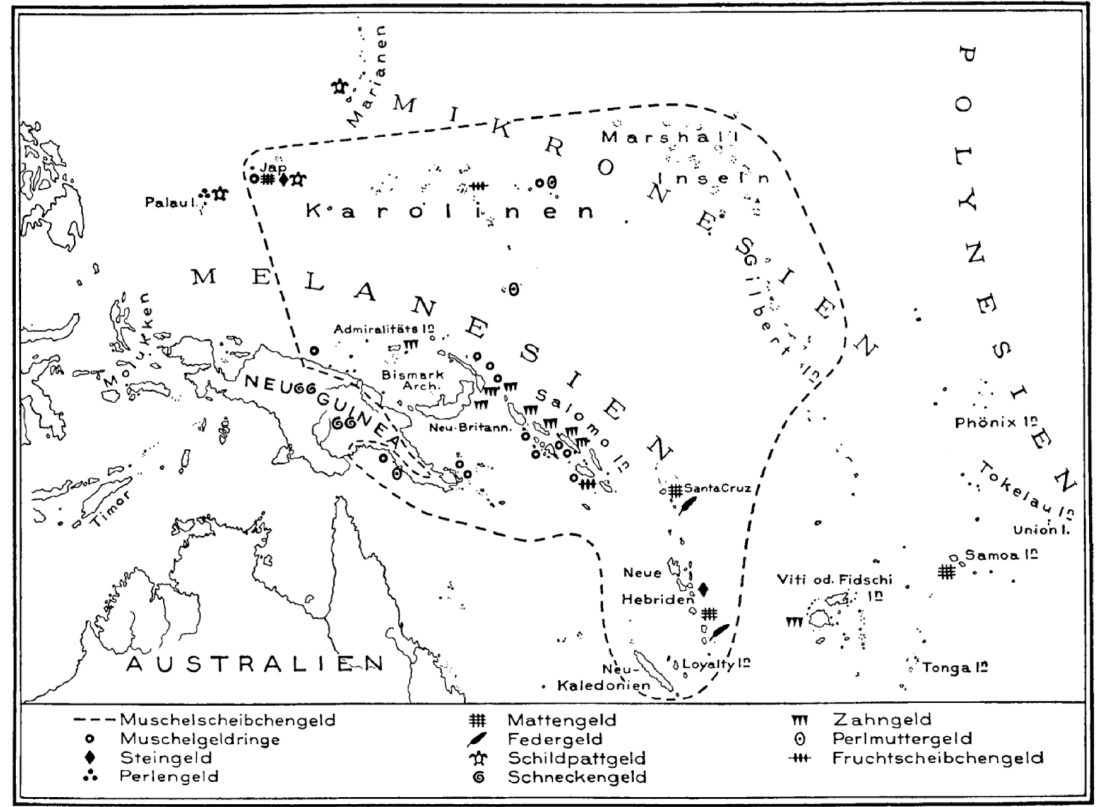
Figure 2: The broken line indicates the large area in which the shell money diwara ( Muschelscheibchengeld ) was in use around 1930. Pictograms indicate more locally used media of exchange like teeth, woven mats, stone disks, or feathers. Petri, “Die Geldformen,”